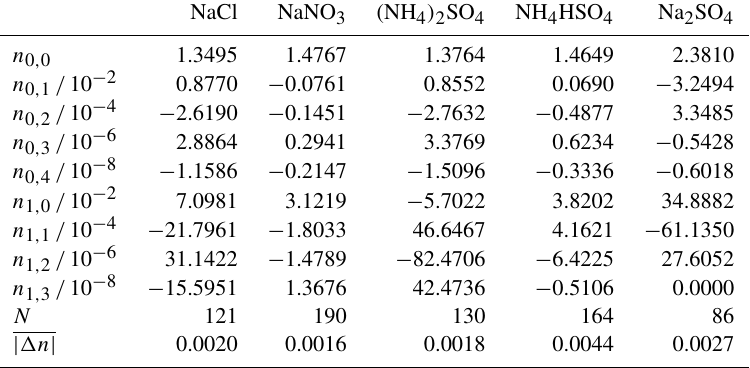
Table 2. Summary of the best-fit parameters to describe the RI variation with both wavelength and RH for the inorganic solutes of interest. The parameters and function forms are defined in Eqs. (7)–(9). N is the total number of measured and literature data points (shown in Fig. 5) to which the parameterisation was fitted. | (cid:49)n | is the mean absolute difference between the best-fit Cauchy model and the measured and literature